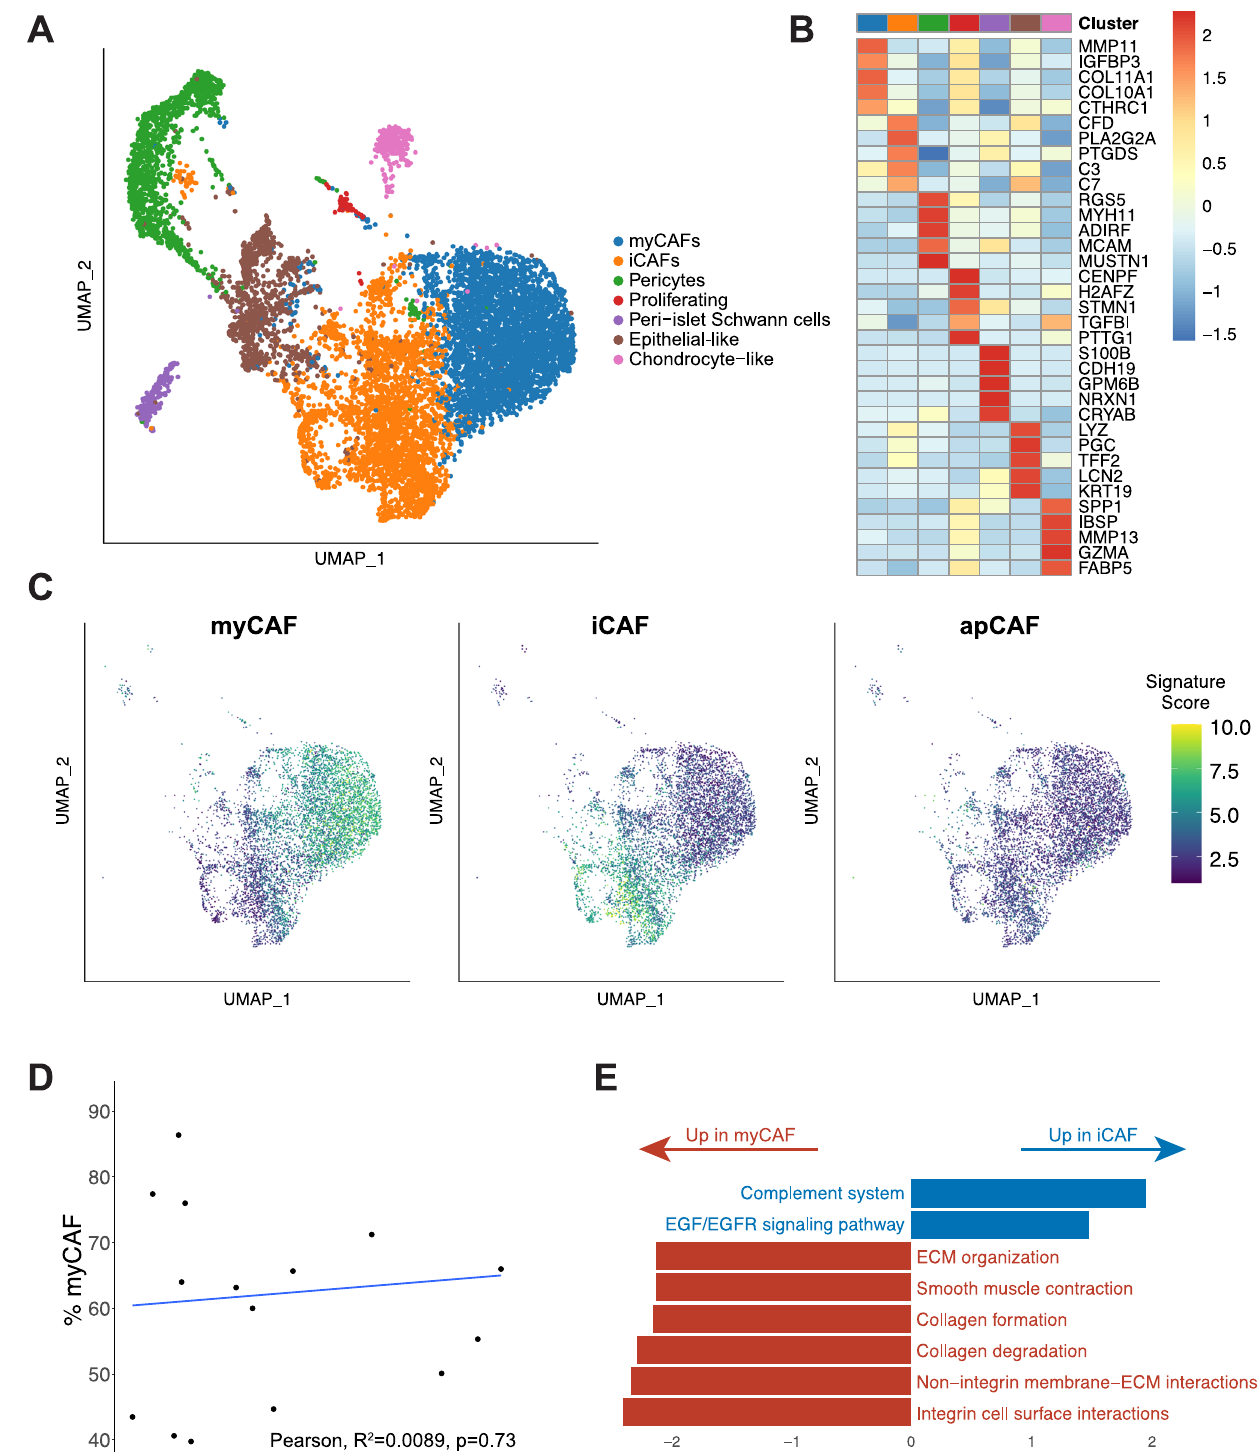
Fig. 3 | Charting the CAF landscape in the PDAC tumor microenvironment. A UMAP overview of the mesenchymal compartment. CAF cancer-associated fi broblast, iCAF in fl ammatory CAF, myCAF myo fi broblastic CAF, UMAP uniform manifold approximation and projection. B Heatmap of the fi ve most differentially expressed genes within each cluster. Colors correspond to the cluster colors in panel( A , C ).iCAF,myCAF,andapCAFsignaturesfromElyadaetal. 19 overlaidonthe UMAP embedding of our mesenchymal compartment. The iCAF and myCAF sig- natures are derived from human fi broblasts; the apCAF signature is derived from KPC mouse fi broblasts. apCAF antigen-presenting CAF. D Assessment of